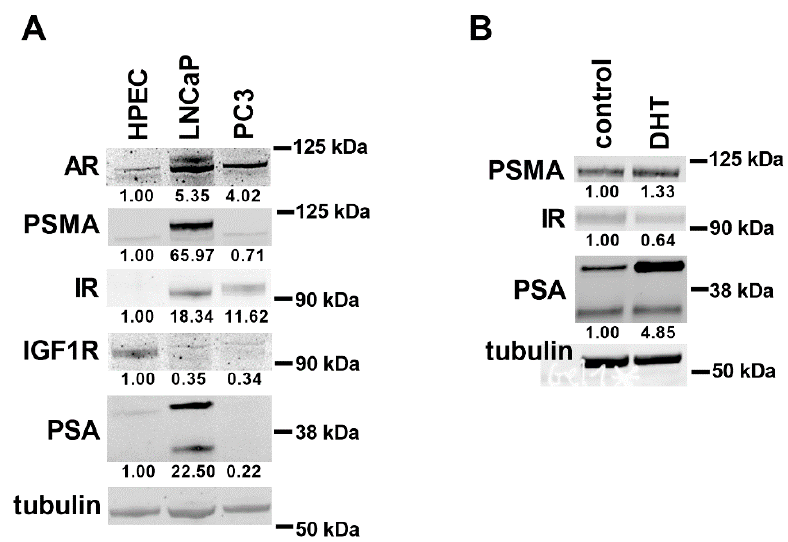
Figure 4. Protein levels of androgen receptor (AR), PSA, prostate-specific membrane antigen (PSMA), insulin receptor (IR), and insulin-like growth factor 1 receptor (IGF1R) in prostate-cancer cell lines. Proteins detected using SDS-PAGE and Western blot. ( A ) For HPEC, LNCaP, and PC3 cell lysates, AR, PSA, PSMA, IR, and IGF1R antibodies were applied. ( B ) For LNCaP cell lysates, PSA, PSMA, and IR antibodies were applied. As loading control, β -tubulin was used. Protein intensities were normalized to ( A) β -tubulin and HPEC cells or ( B ) control condition. These relative protein intensities are under the pictures. For quantifying PSA intensity, upper protein bands were evaluated. Control: LNCaP cells grown in growth medium; DHT: dihydrotestosterone treatment of LNCaP cells after serum deprivation. Numbers on the right side represent molecular-weight markers.